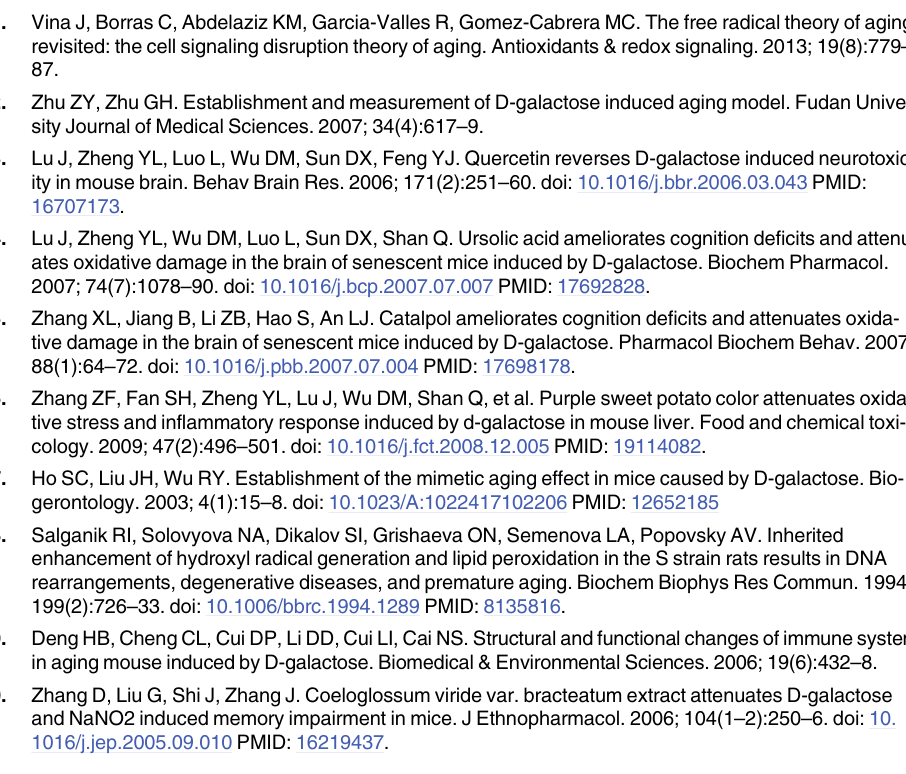
S4 Table. Details of significant mRNA changes induced in liver of D-galactose group. S5 Table. The results of total RNA extraction. S6 Table. Standardize data of mRNA chip. S7 Table. The technology roadmap of our experiment and the explanation of supporting